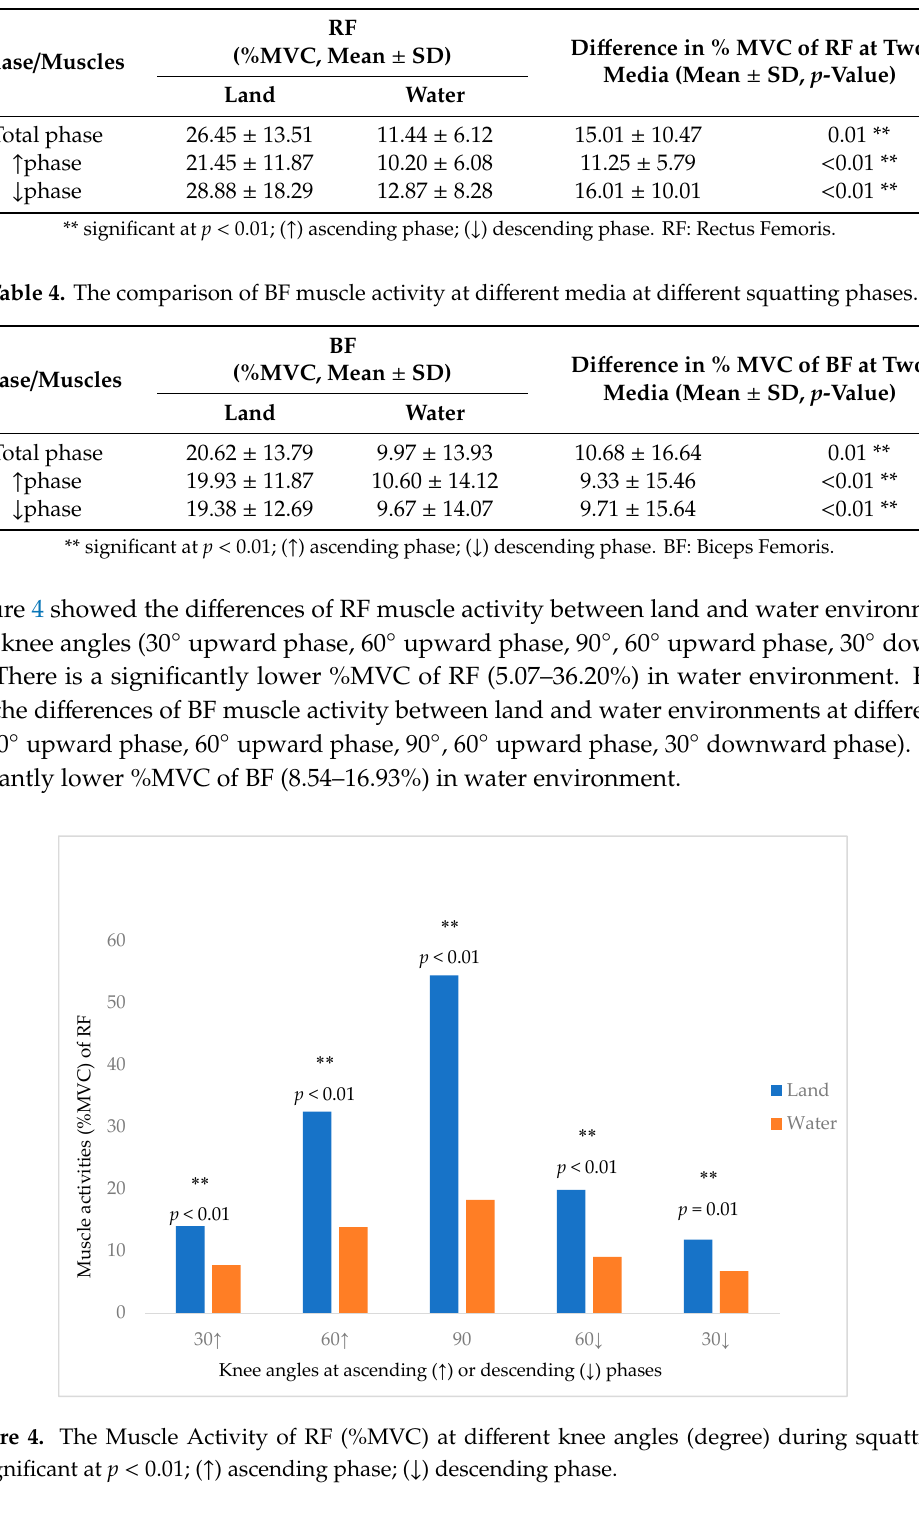
Figure 5. The Muscle Activity of BF (%MVC) at different knee angles (degree) during squatting. * significant at p < 0.05, ** significant at p <0.01; ( ↑ ) ascending phase; ( ↓ ) descending phase .